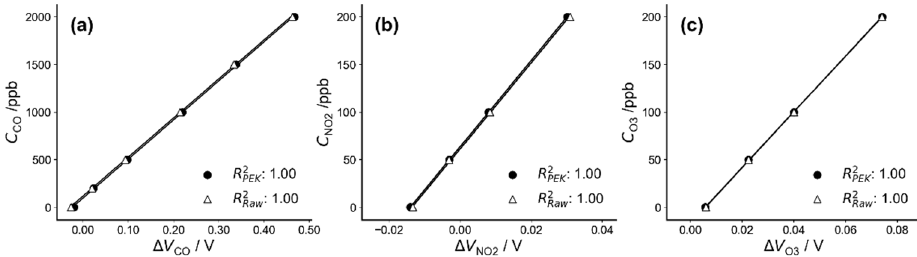
Figure 2. Correlation coefficients of baseline-corrected output as a function of raw sensor output for ( a ) CO, ( b ) NO 2 and ( c ) O 3 under controlled laboratory conditions (T = 22 °C, RH = 55%).